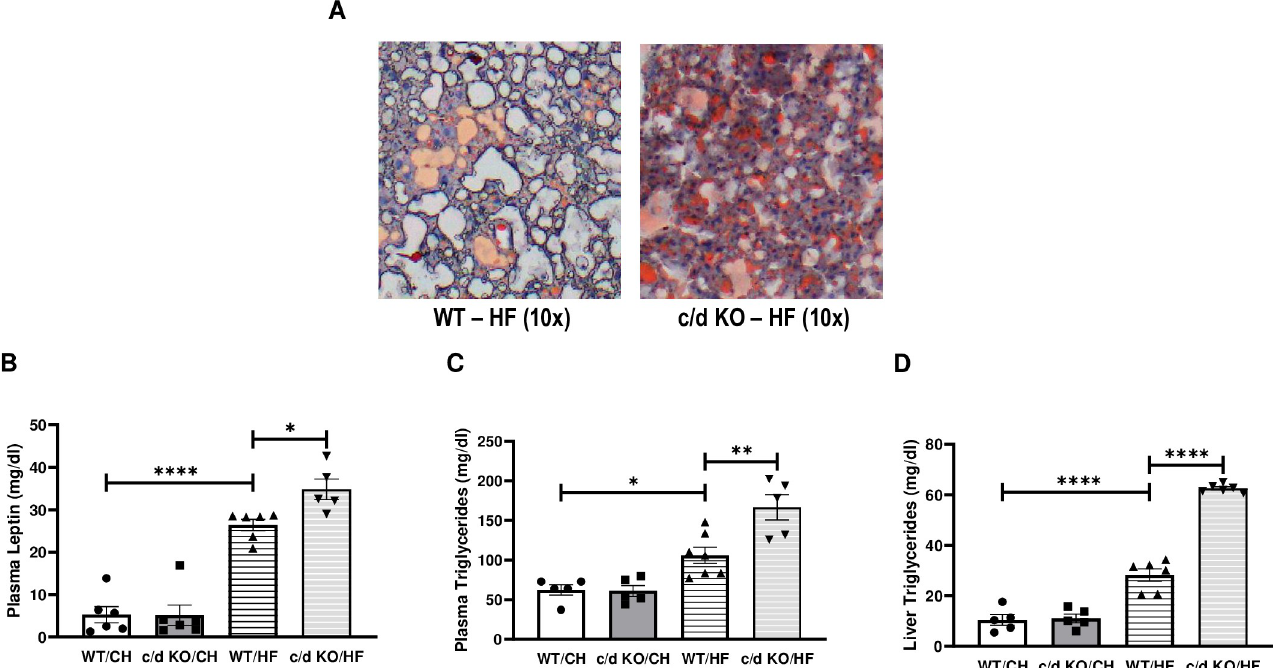
Fig 4. Effect of high-fat (HF) diet on the liver of c/d KO mice. (A) Liver Oil-Red-O staining for lipid droplets. Analysis of plasma leptin levels (B) , plasma triglyceride levels (C) , and liver triglyceride content (D) in WT and c/d KO groups fed normal chow or a HF diet. Data are expressed as mean ± SEM (n = 5–7 mice/genotype/diet). � p < 0.05 by Bonferroni post hoc analysis after intergroup differences were found by 1-way ANOVA. � p < 0.05, �� p < 0.01, ���� p < 0.0001 by two-sample t-test.